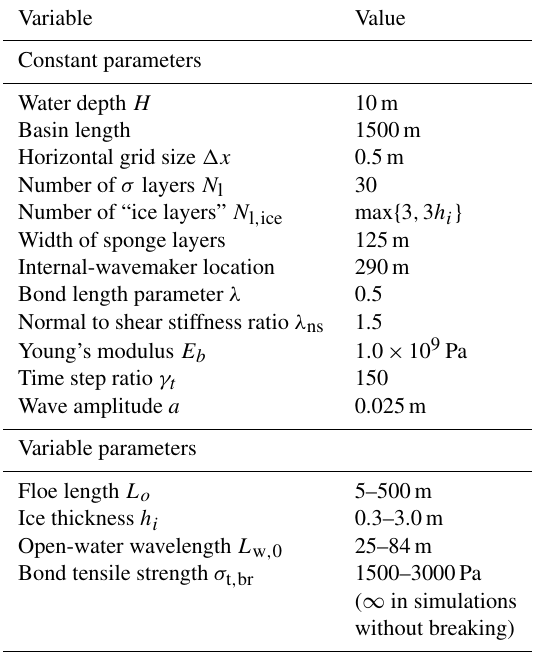
Table 1. Model parameters used in the simulations in Sect.